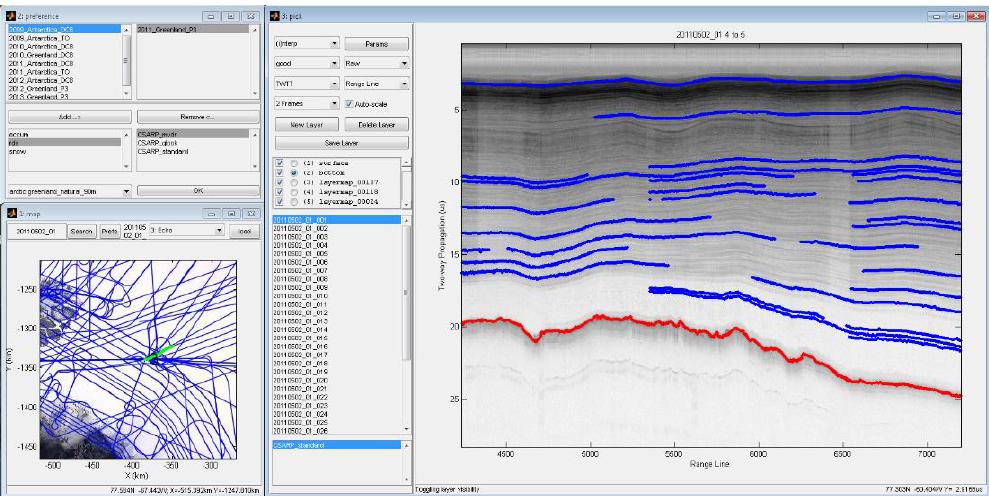
Figure 8. The CReSIS MATLAB Data Picker user interface.